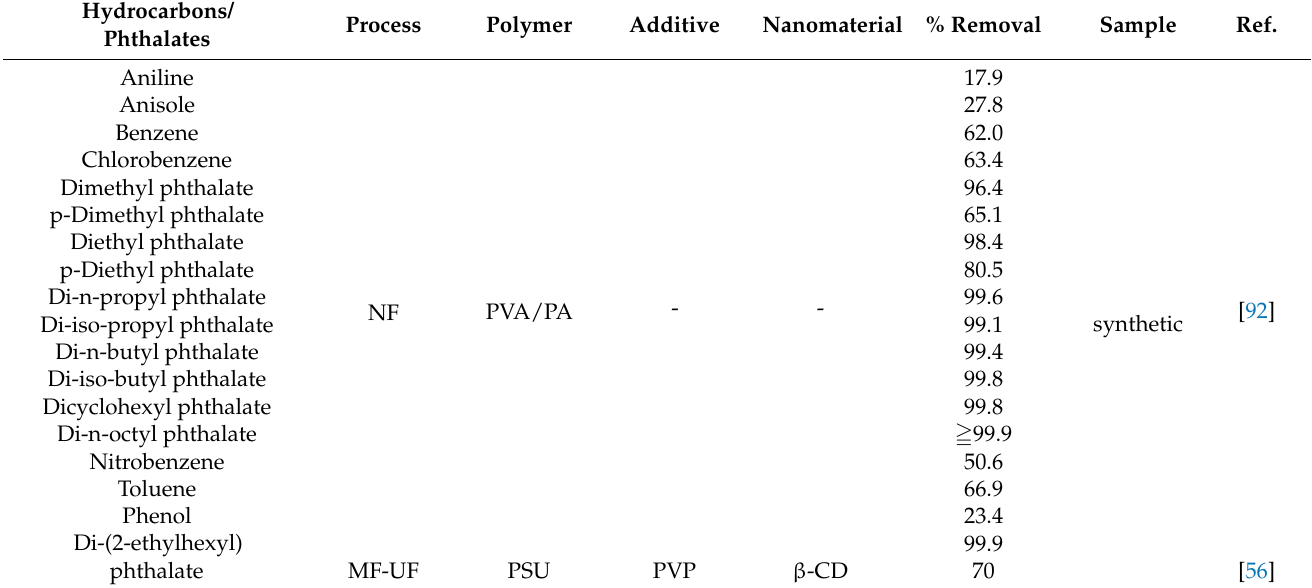
Table 7. Application of polymeric membranes in the purification of water contaminated with polycyclic Aromatic Hydrocarbons (PAHs) and Phthalates